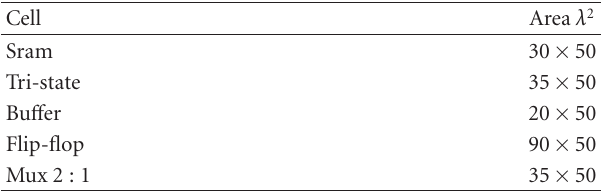
Table 1: Standard cells characteristics.